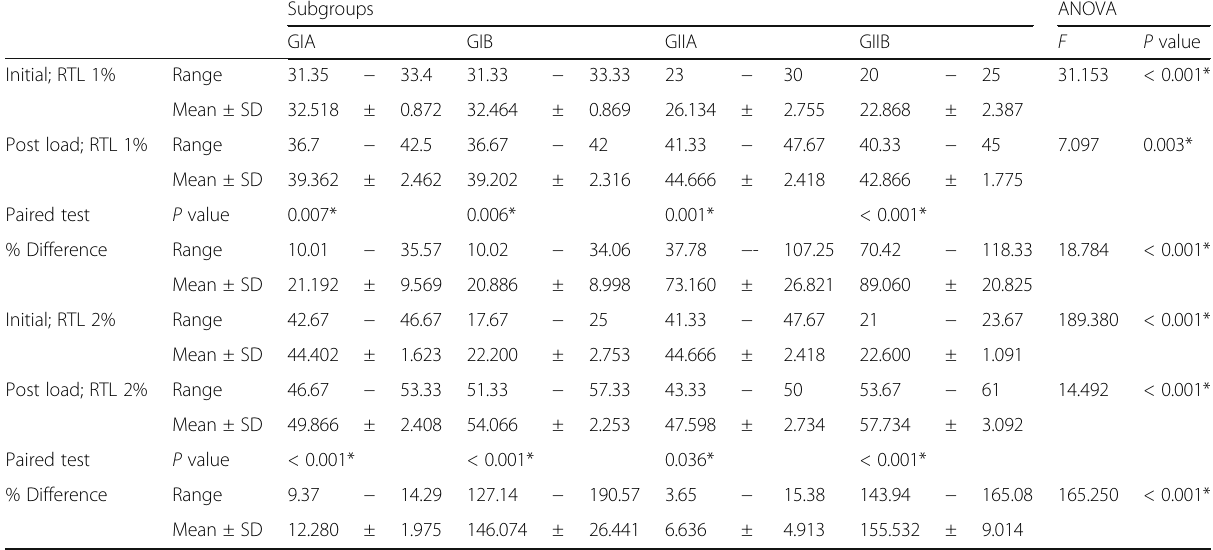
Table 7 One way ANOVA test comparing between all subgroups regarding percentage initial, percentage post load, and percentage difference between initial and post load (RTL 1 ) and percentage initial, percentage post load, and percentage difference between initial and post load (RTL 2 )